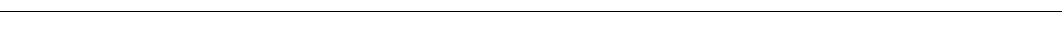
Figure 8 | Characterization of the a -gH mAb epitopes. ( a ) Spot intensities were quantified following incubation of 5C3 followed by anti-mouse Dylight680 mAb with overlapping conformational gH peptide libraries of 7 amino acids (aa; black), 10aa (blue) and 13aa (red; left panel). Reactivity of 5C3 with overlapping peptide series near the region of peak binding are shown (right panel). Data represents mean intensity from duplicate samples. ( b ) The region of 5C3 reactivity is located between aa’s 481–495 within domain 2 of gH. The region includes a b -sheet (blue) and a 10aa-long alphahelical region (red). ( c ) Structural modeling of CMV-gH based on the crystal structure of HSV-1 indicates the location of the putative epitope (blue; left). Predicted surface interactions indicate that the 5C3-reactive alpha helical region is exposed on the surface of gH (circle; right). ( d ) 293 cells transfected with gL and a transfection control, wild-type gH, gH mutant 478–79 or gH mutant 168 were stained with MSL-109 (top row), 10C10 (middle row) or 5C3 (bottom row). Percentage of cells positive for gH are indicated. ( e ) 293 cells transfected with gL and gH mutant 480–86 or 485–92 were stained with MSL-109 (top row), 10C10 (middle row) or 5C3 (bottom row). Percentage of cells positive for gH are indicated. ( f ) The data from Fig. 6e was quantified and normalized compared with WT binding. ( g ) Binding of MSL-109 (black), 5C3 (blue) and 10C10 (red) to 293 cells transfected with gH containing 2aa alanine substitutions along the length of the epitope region was measured. Percentage of gH-positive cells compared with WT-transfected cells was calculated and plotted. ( h ) The epitope region from 12 geographically distinct CMV strains were aligned to the TB40/E sequence. ( i ) U373 gH/gL cells were exposed to murine, chimeric and humanized 5C3 mAbs and analyzed by flow cytometry with cells exposed to an isotype control (grey peak). ( j ) Murine, chimeric and humanized 5C3 mAbs were pre-incubated with AD169 IE2-YFP at various concentrations before exposure to MRC5 fibroblasts. Infection levels were measured and compared with an isotype control. Data in d – g , i , j represents duplicates from three experiments. S.d. is depicted in all relevant figures. * P o 0.05 (Student’s two-tailed t